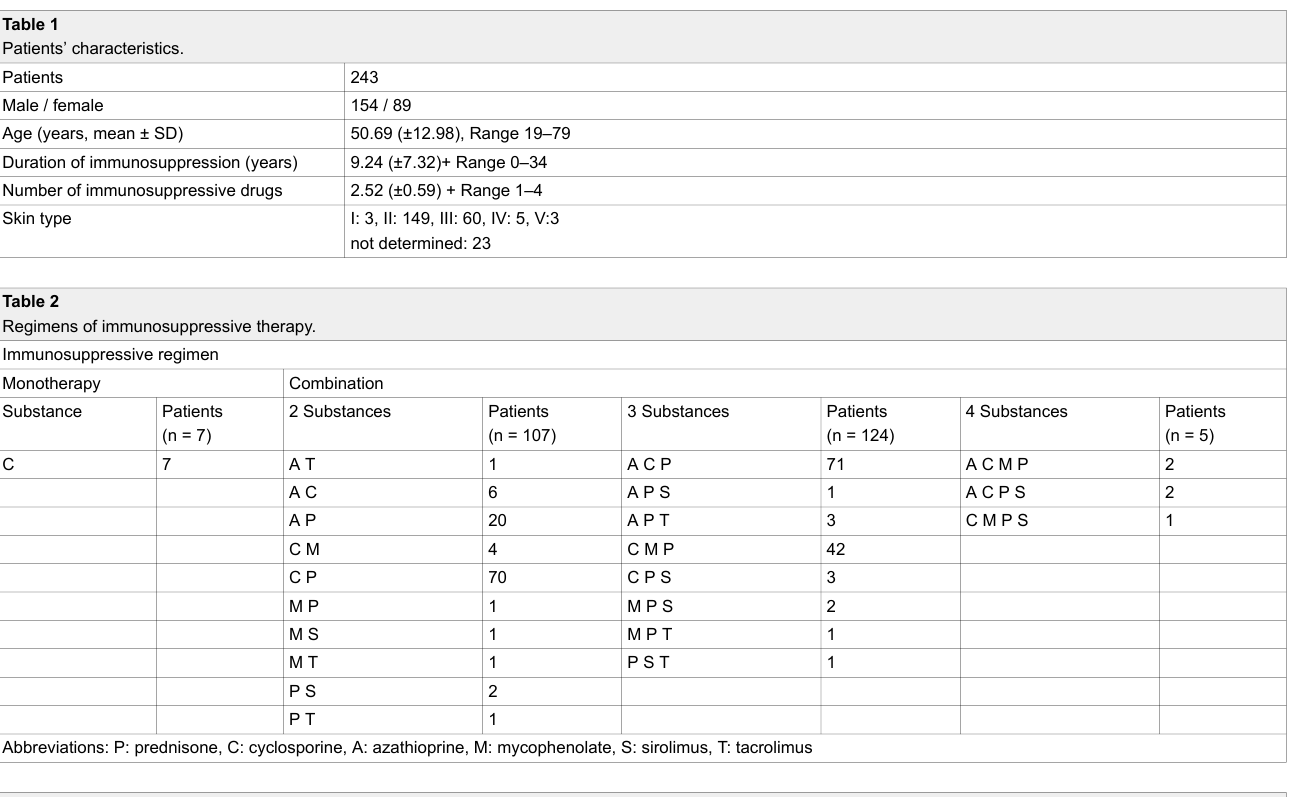
Table 3 Effects of age, sex, duration of immunosuppressive therapy, regimens of immunosuppressive therapy on the occurrence of actinic keratoses (A) and squamous